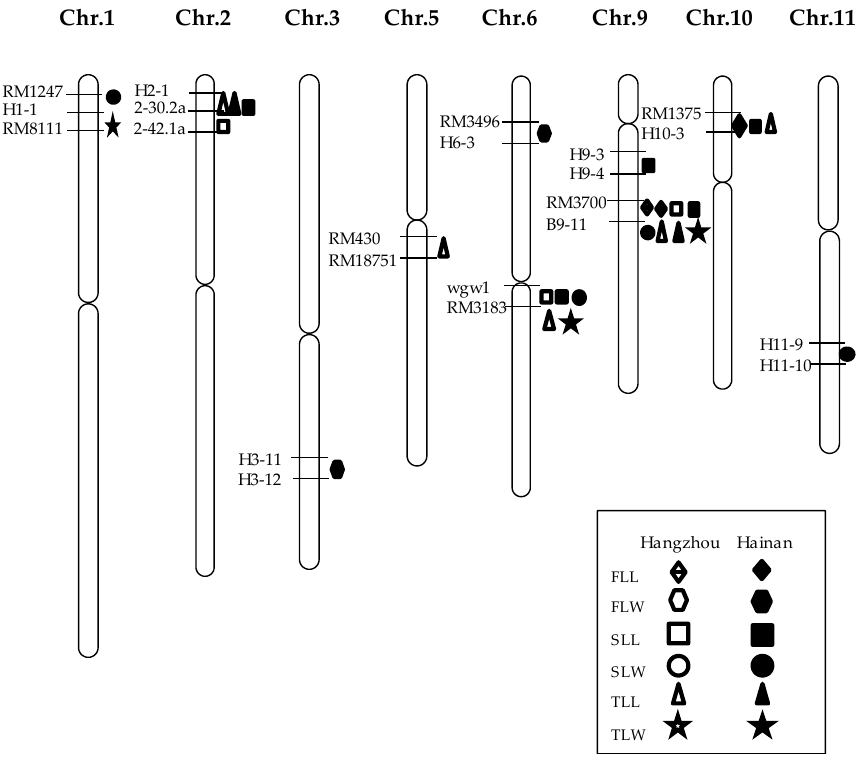
Figure 3. Locations of quantitative trait loci (QTLs) for leaf traits in the genetic map. FLL: flag leaf length; FLW: flag leaf width; SLL: the second leaf length; SLW: the second leaf width; TLL: the third leaf length; TLW: the third leaf width.